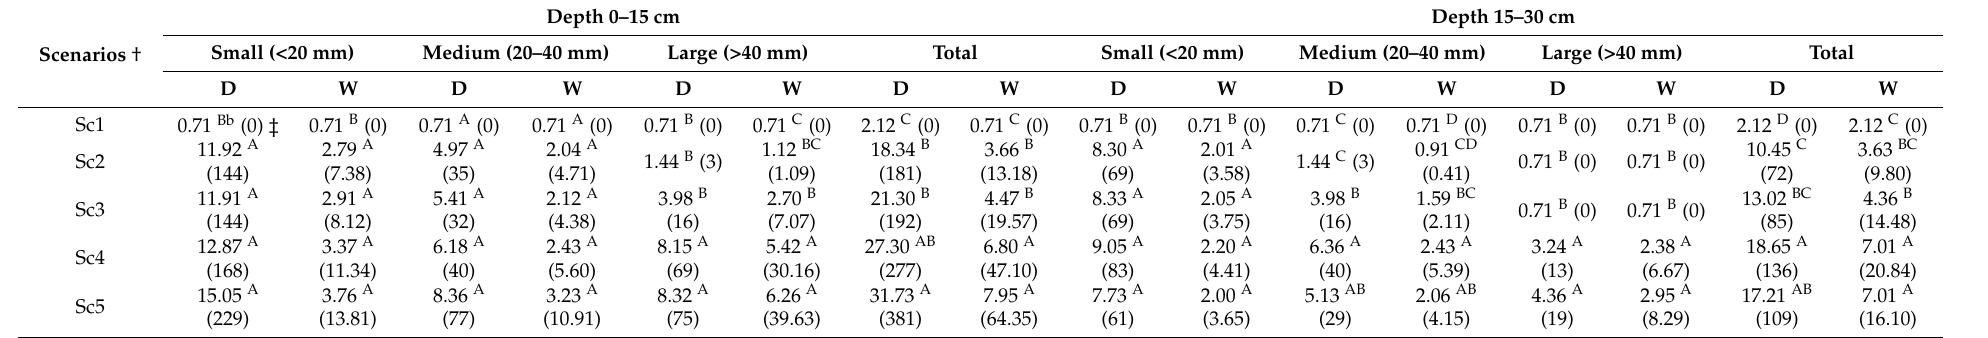
Table 2. Earthworm density (individual m − 2 ) and biomass weight (g m − 2 ) under long-term CSA-based management practices (data transformed through square-root